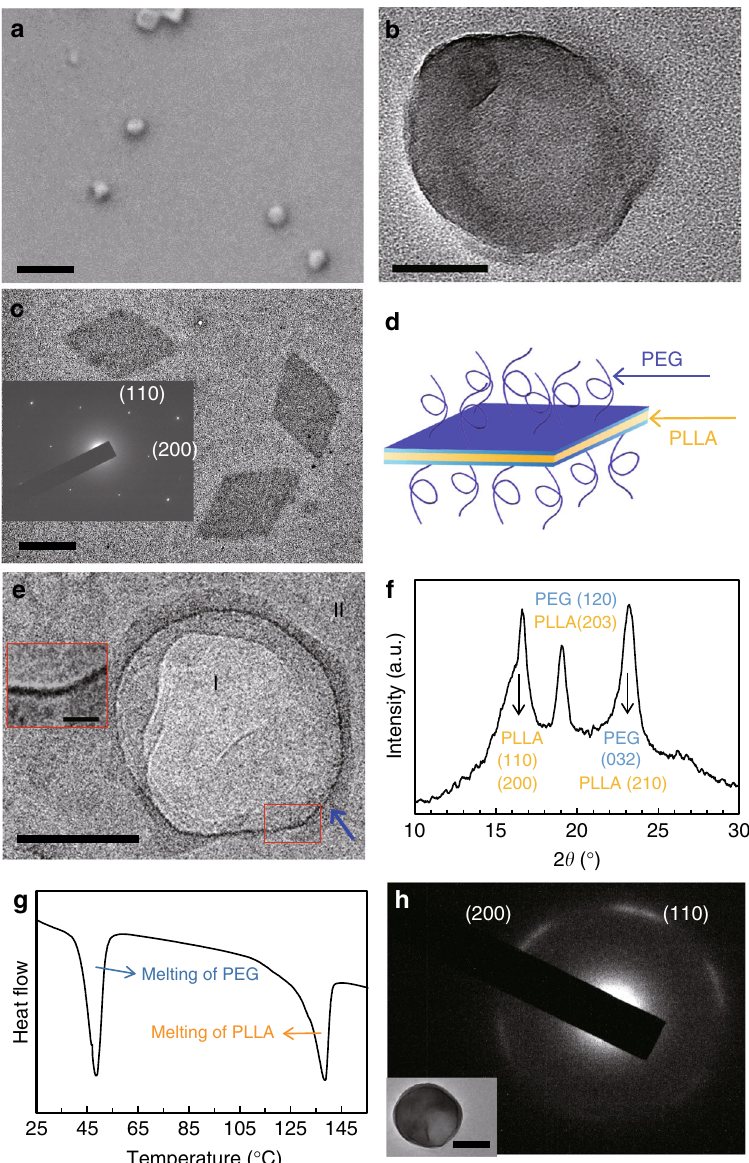
Fig. 2 Morphology and crystal structure of PLLA- b -PEG single crystal and BCCs. a SEM and b TEM micrographs of BCCs in dried state. c TEM micrograph of fl at PLLA- b -PEG polymer single crystals grown from toluene with an SAED pattern and the corresponding schematics ( d ). e A representative cryo-TEM micrograph of BCCs in water. Inset of e is an enlarged image highlighting the BCC wall. f WAXD pattern, g a DSC fi rst heating thermogram and h an SAED pattern of PLLA- b -PEG BCCs. Inset of h shows a corresponding BCC bright fi eld TEM micrograph. Scale bars in a , b , c , e , inset of e , h are 500, 100, 500, 50, 10, and 200 nm,